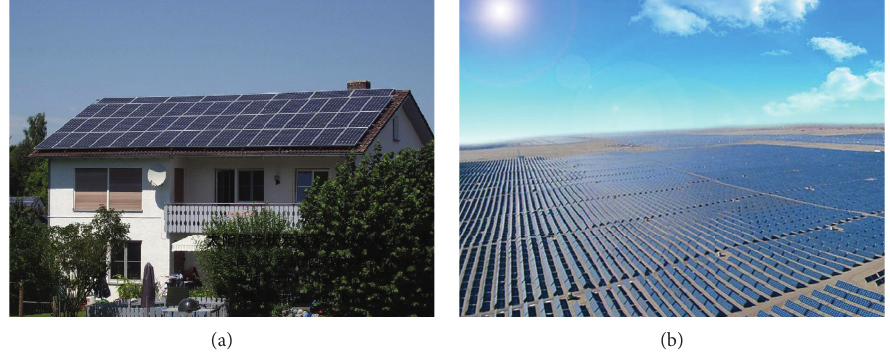
Figure 1: The PV power systems: (a) distributed PV system and (b) centralized PV power plant.